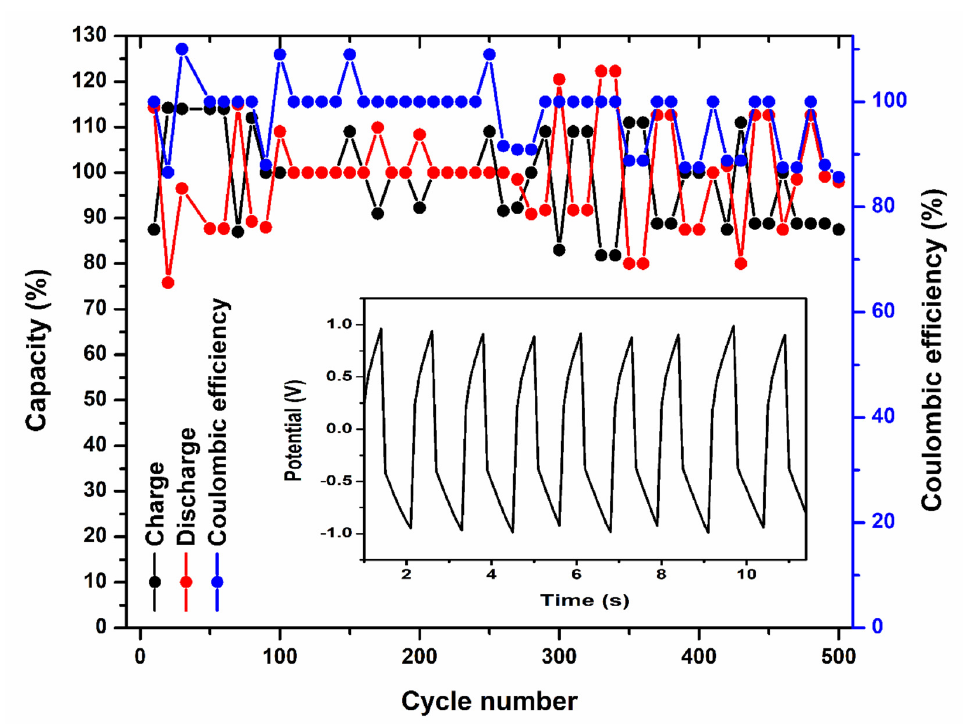
Figure 10. Prolonged cycle performance of prototype battery with PVA-20 wt% TEOS (PE-1) at a current density of 0.5 mA cm − 2 .